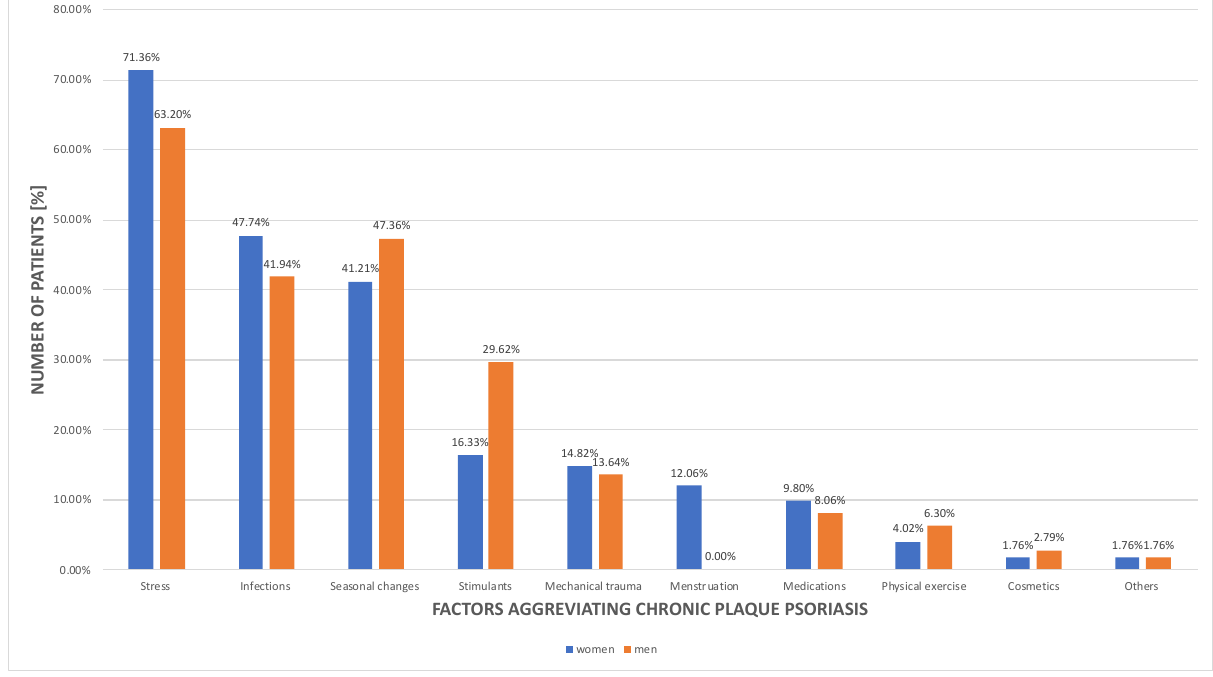
Figure 6. Patients’ subjective assessment of the factors aggravating the psoriasis disease course.